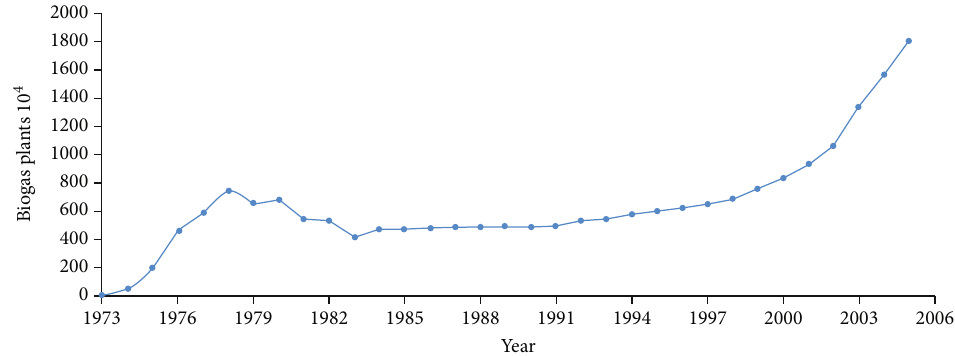
Figure 4: Number of biogas plants between 1973 and